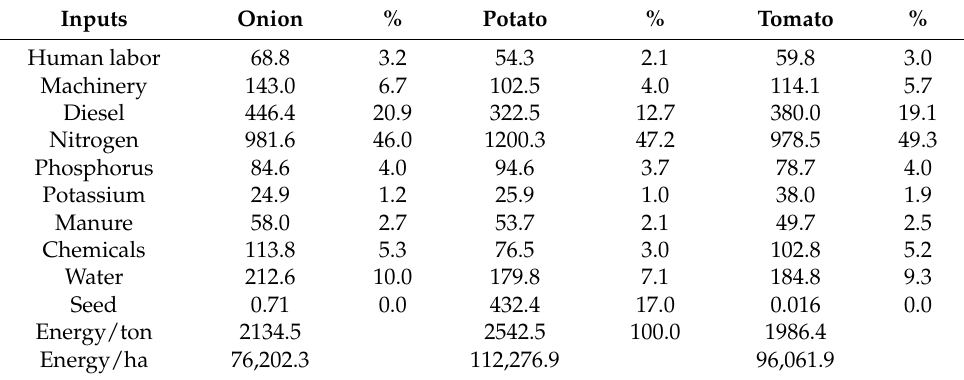
Table 2. Energy equivalent (MJ/ton) of inputs of the cultivation processes of vegetable crops.